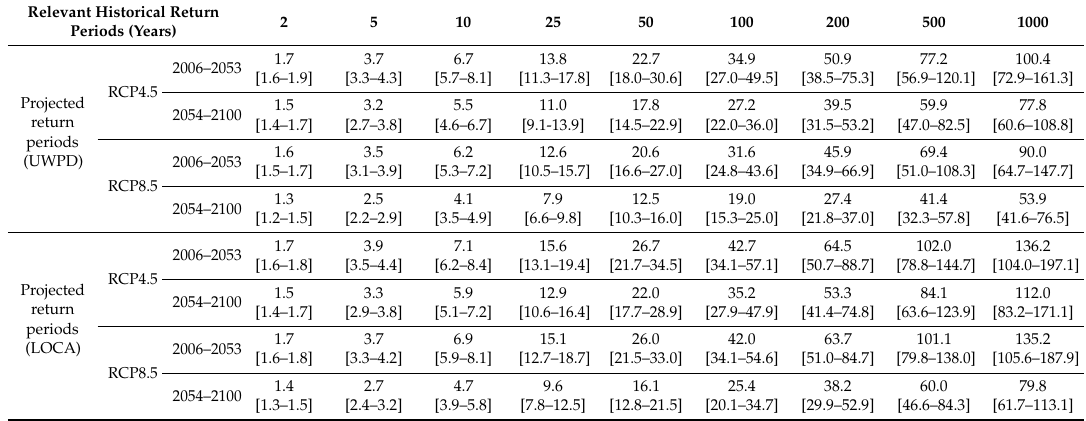
Table 2. Northeastern US domain averaged return periods with their uncertainties expressed as +/ − one standard deviation of the ensemble under RCP4.5 and RCP8.5